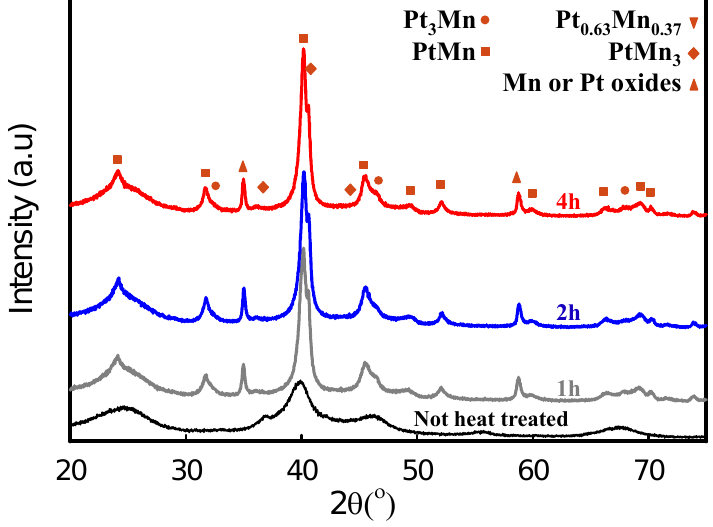
Figure 5. The XRD patterns of the sample prepared in the presence of 2X sodium citrate (SC) and after heat treatment at 700 °C for different